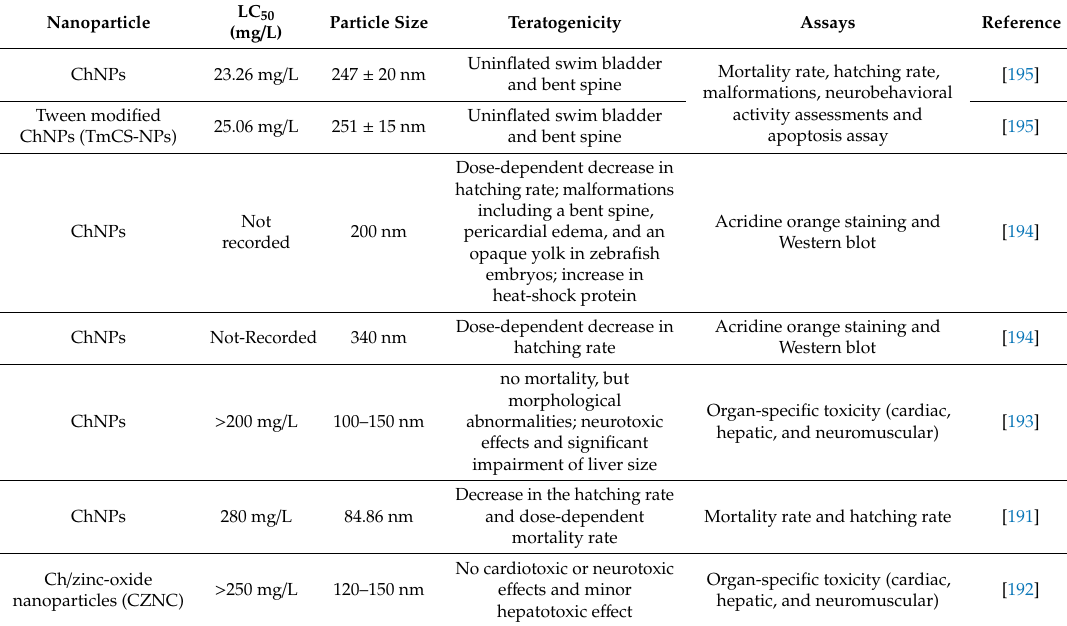
Table 3. Summary of the five studies of chitosan nanoparticle toxicity using a zebrafish model.